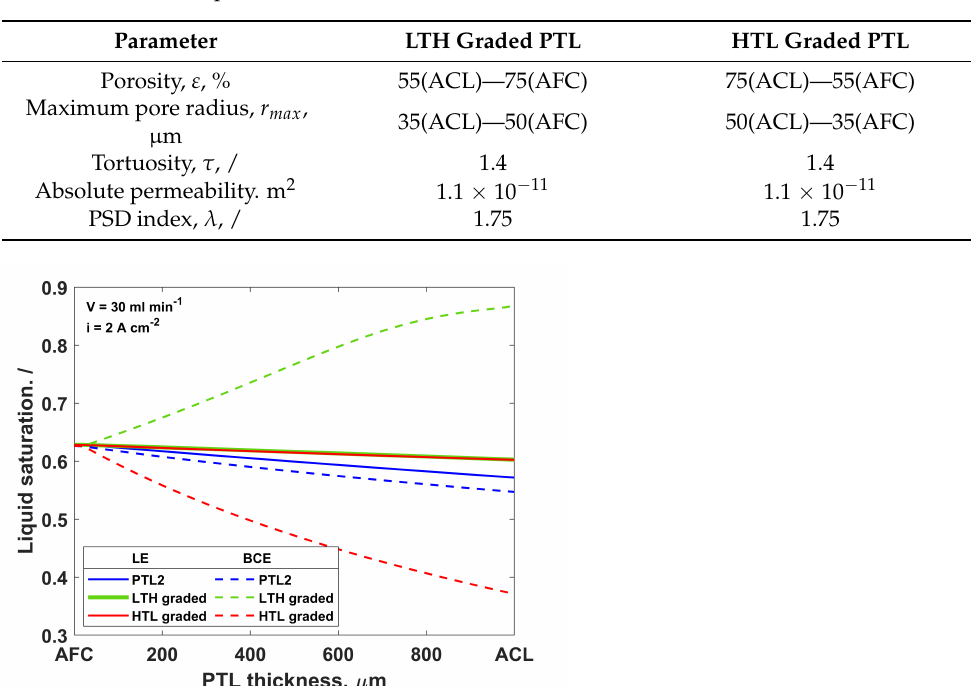
Table 3. Graded PTL parameters.